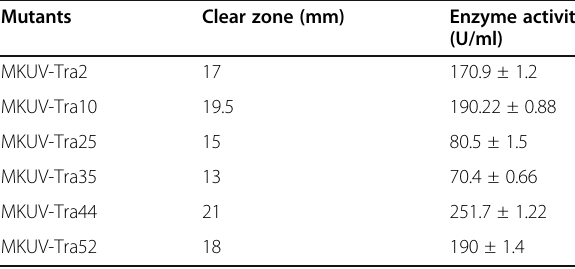
Table 2 Screening of β -galactosidase productivity for the best trans-conjugant isolate (Tra210) after UV mutagenesis Mutants Clear zone (mm) Enzyme activity